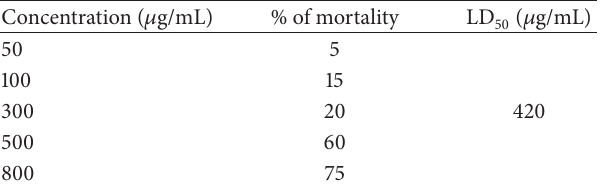
Table 4: Cytotoxic effect of MEMA leaves on shrimp nauplii. Cyto- toxicity effect of MEMA at various concentrations on the viability of brine shrimp nauplii was examined after 24 hrs